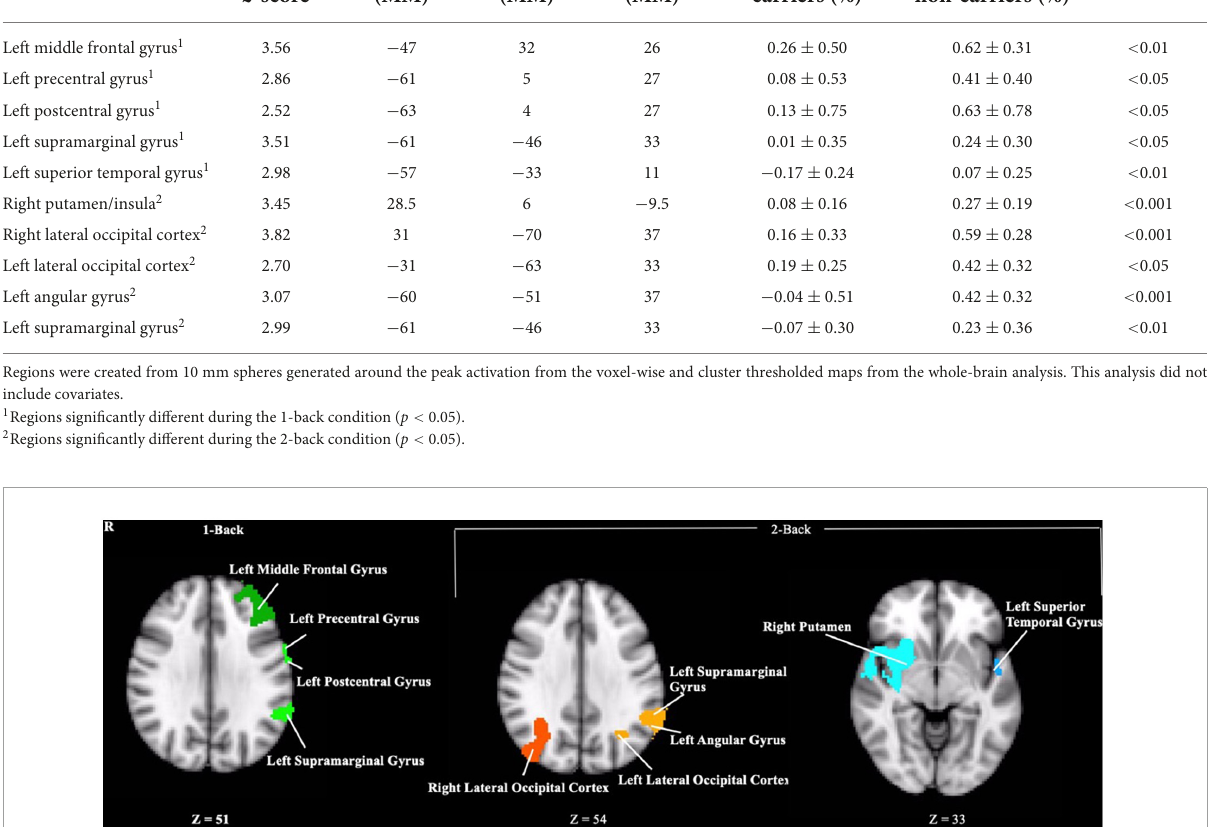
not associated with activation during any condition of the n-back task. Similarly, BMI was not associated with accuracy or reaction time during the 1-back or 2-back conditions ( p s >